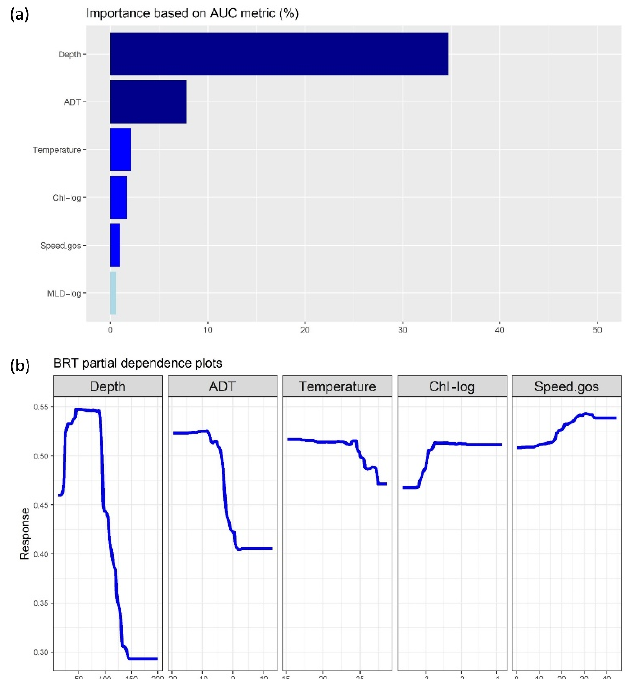
Figure 4. RF results: ( a ), barplots of variable importance scores based on AUC-metric. The dark blue, blue and light blue colored bars indicate variables with high significance ( p -value < 0.01), moderate significance (0.01 ≤ p -value < 0.05) and no significance ( p -value ≥ 0.05), respectively. ( b ), partial plots of significant ( p < 0.05) parameters are shown.